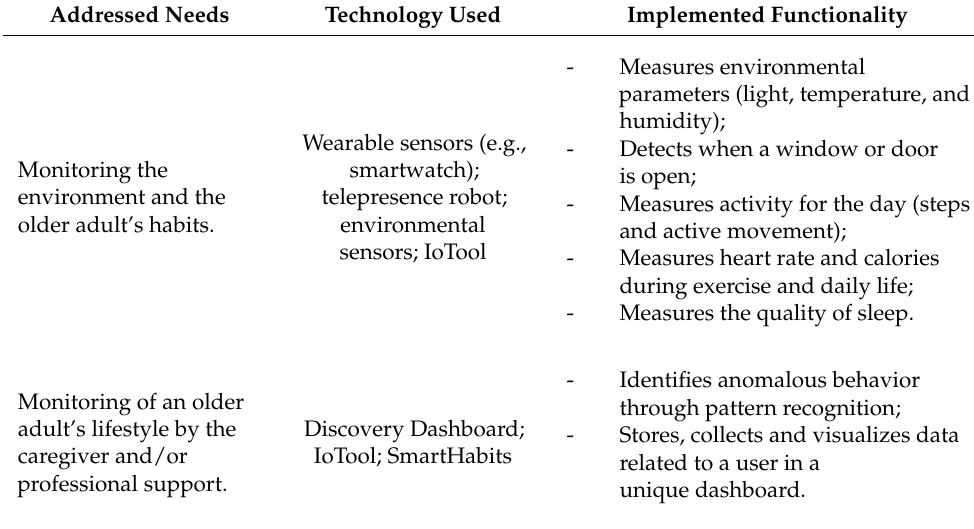
Table 1. Health management and monitoring scenarios.